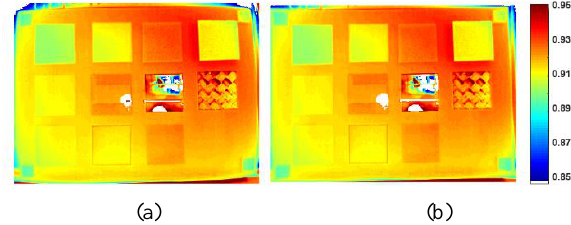
Figure 5. The resulting averaged depth images before (a) and after (b) the distortion correction. The colour scale represents the measured distances in meters